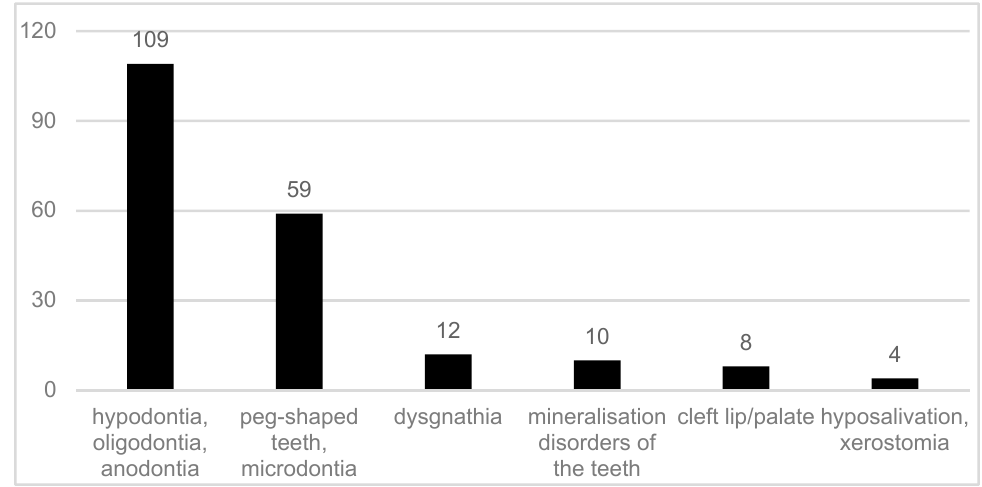
Figure 1. Reported oral symptoms in 109 participants with ectodermal dysplasia.